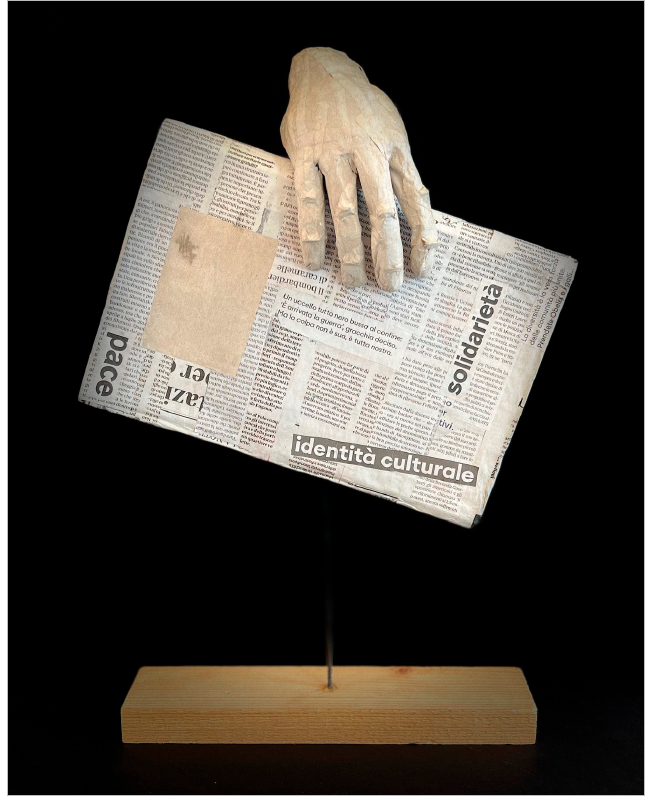
Fig. 6 Student of the Visual